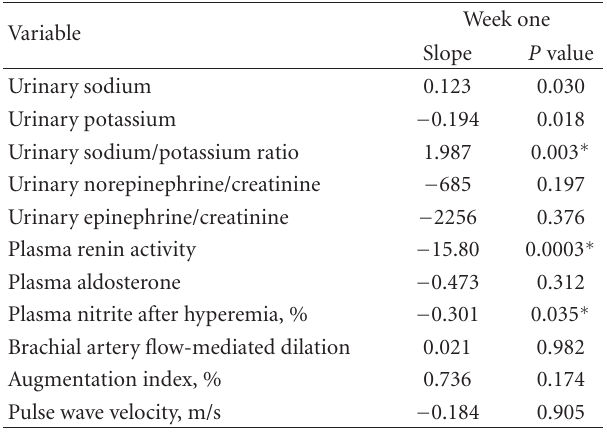
Table 5: Simple regression of SBP changes on changes in individual biological and vascular variables at week